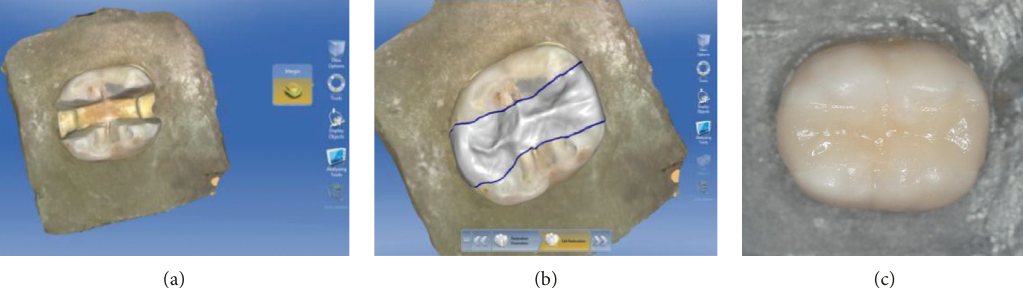
Figure 1: (a) Digital impression of a preparation in CEREC Omnicam. (b) Restoration design of Lava Ultimate restoration. (c) Lava Ultimate inlay restoration after